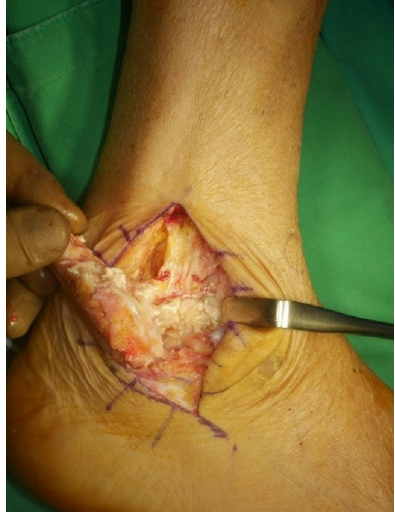
Figure 3. After exposure of the distal fibula, the fibula was transected 4 to 5 cm proximal to the ankle joint.